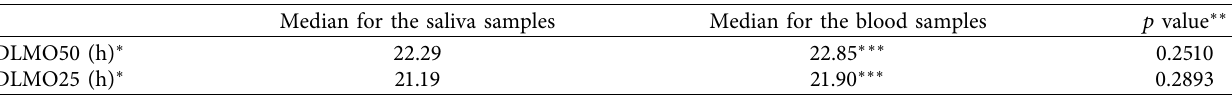
Table 4: The comparison of the DLMO parameters obtained from the salivary and blood melatonin secretion profiles. Median for the saliva samples